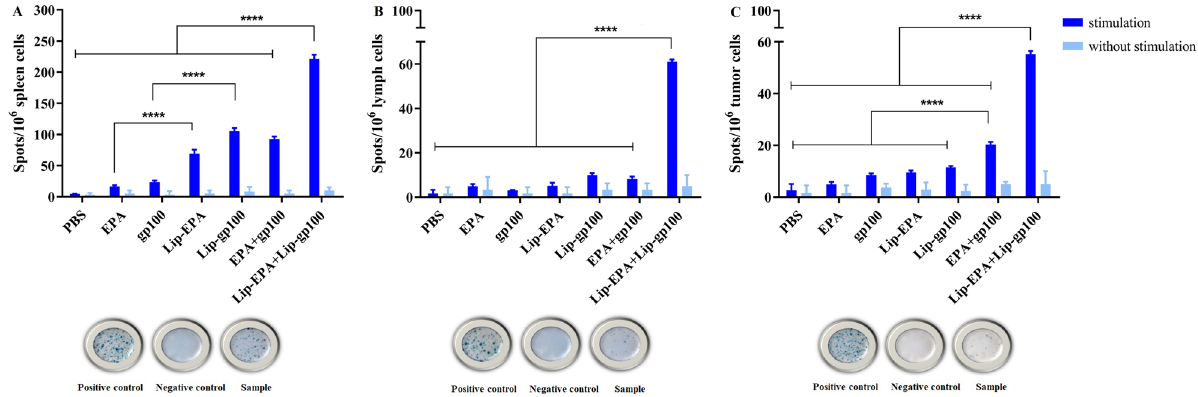
Figure 5. Interferon (IFN)-γ-secreting cells in spleen, lymph node and tumor tissues of the different treatment groups. IFN-γ-producing cells in ( A ) spleen, ( B ) lymph node and ( C ) tumor site as spot-forming cells (SFCs)/1000,000 cells. Data are represented as mean ± standard deviation (n = 3). ****p < 0.0001.